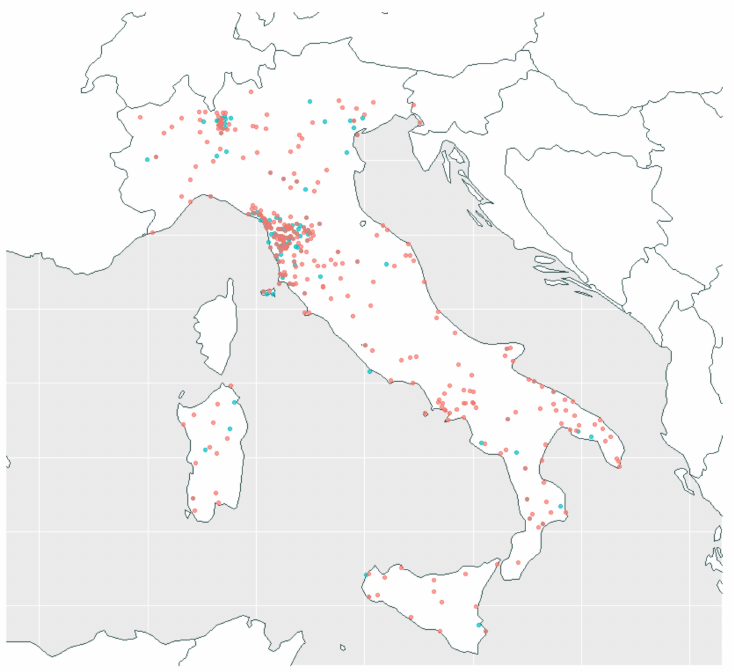
Figure 2. Map of municipalities of residence (207, in blue) and places of birth (407, in red) of screened